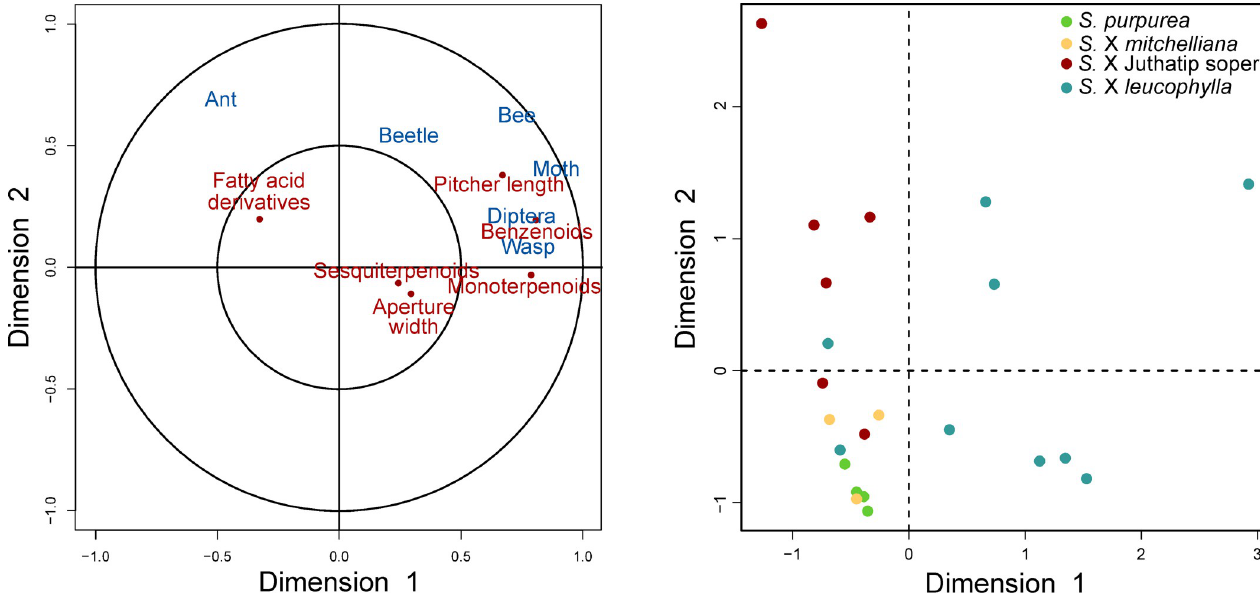
Fig 5. Canonical correlation analysis of plant and prey quantitative variables. Canonical correlation analysis between plant quantitative variables pertaining to odour & morphology and prey quantitative variables pertaining to the different insect groups trapped. (A) Representation of the plant (red) and prey (blue) variables on the correlation circle of the first two canonical axes. (B) Representation of the pitchers on the first two canonical